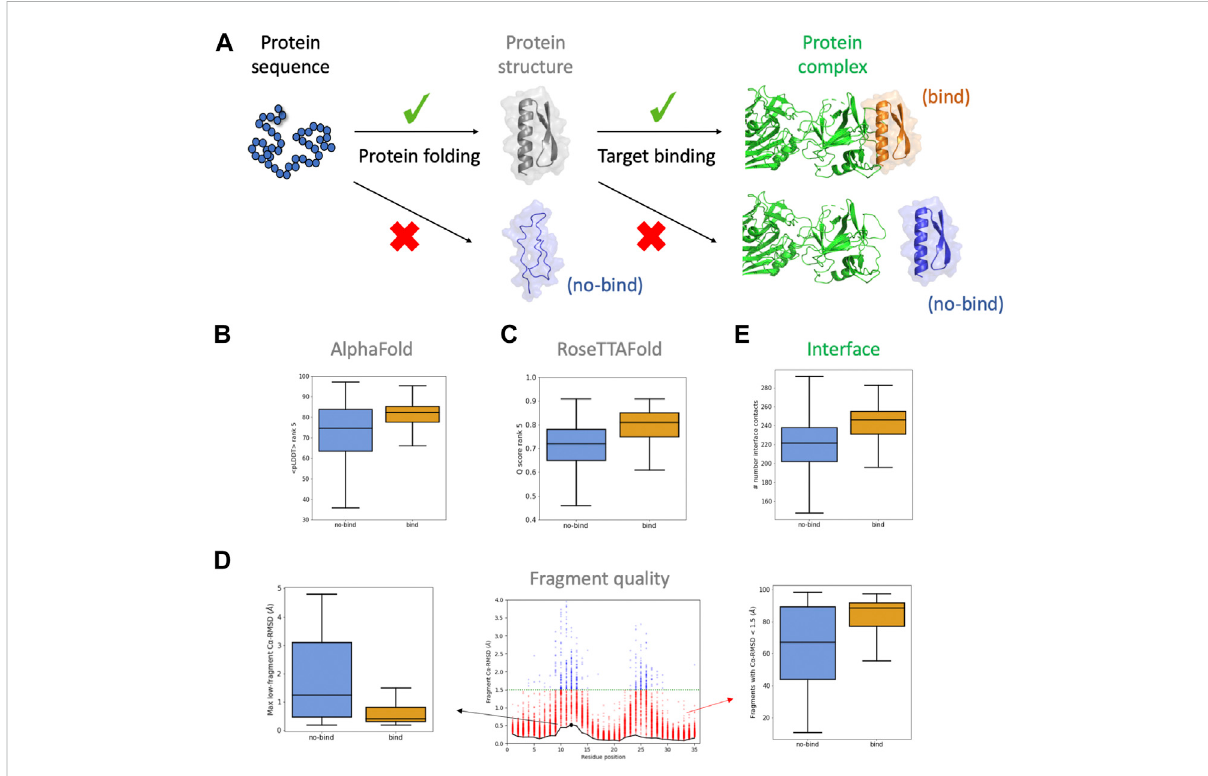
FIGURE 1 Descriptors considered for the BoNT dataset. (A) For designed sequences to bind their target, they require to fold correctly and present a complementarybindinginterface. (B,C) boxplotsforcon fi dencescoresoftherank#5modelsobtainedfromAlphaFold (B) andRoseTTAFold (C) . (D) boxplotsfordescriptorsobtainedfromthefragmentqualityanalysisplot( center ):percentageoffragmentswithRMSD < 1.5 Å( “ %_frag_rms < 1.5 ” ; red dots ), and maximum RMSD of the lowest-RMSD fragment curve ( “ worst_rmsd_best_frag ” ; black dot ). (E) boxplots for the number of interface contacts (only involving carbon atoms). Binding and non-binding designs are colored in orange and blue,